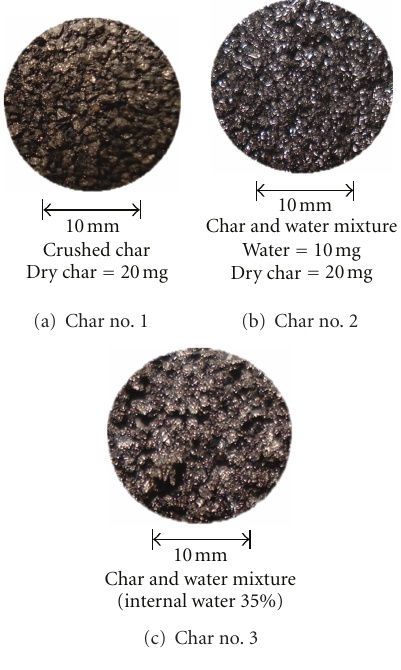
Figure 3: Three kinds of char samples.